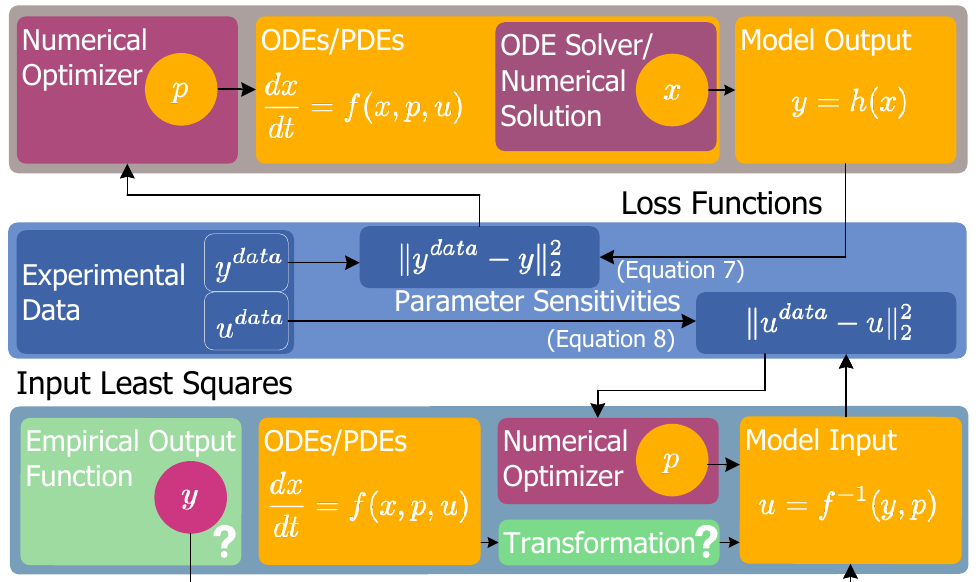
Figure 2. Ordinary Least Squares (OLS) and Input Least Squares (ILS) workflow and their use of experimental data in terms of loss function definitions, process model parameter identification, and parameter sensitivities. For the ILS case, the two open problems, i.e., the definition of the empirical output function and the transformation step for the model input calculation, are highlighted,